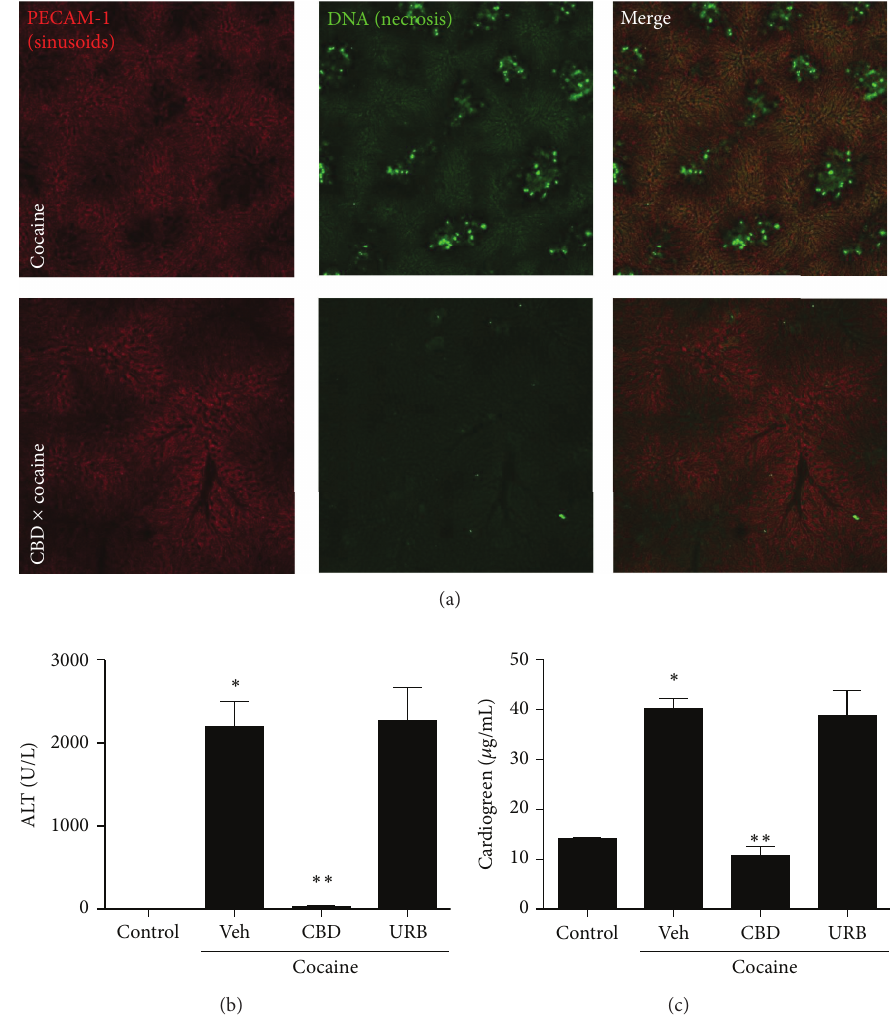
Figure 7: Cannabidiol (CBD; 30 mg/Kg) prevented cocaine-induced liver injury. (a) Liver confocal intravital microscopy showing that while CBD-treated mice have a well perfused liver vasculature (evidenced by PE-anti-CD31 antibody staining, in red) and absence of necrosis (in green), cocaine-treated mice (75 mg/Kg) had several dark areas in the red channel, which are suggestive of malperfusion caused by necrosis (elicited by DNA staining using Sytox Green). (b) Reduced serum liver transaminase levels and (c) clearance of cardiogreen confirmed inhibitionofcocaine-inducedliverinjurybyCBD.However,inhibitionofanandamidehydrolysisbyURBhadnodetectableeffect. ∗ Statistical significance in comparison to controls ( 𝑃 < 0.05 ) and ∗∗ in comparison to vehicle-treated group. A 10x objective was used during imaging. One-way ANOVA with Tukey’s post hoc test. Data are expressed as mean ± S . E . M ( 𝑛 = 6